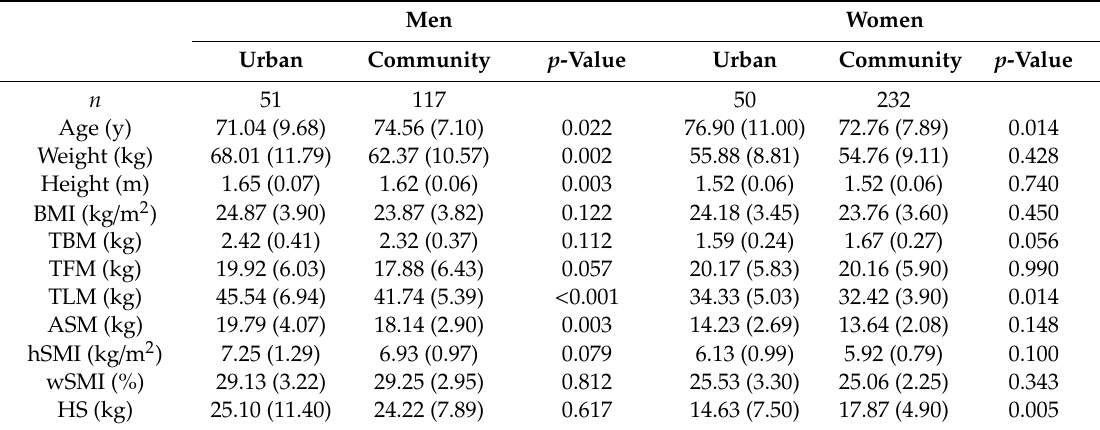
Table 2. Demographics of the studied urban and community-based populations.